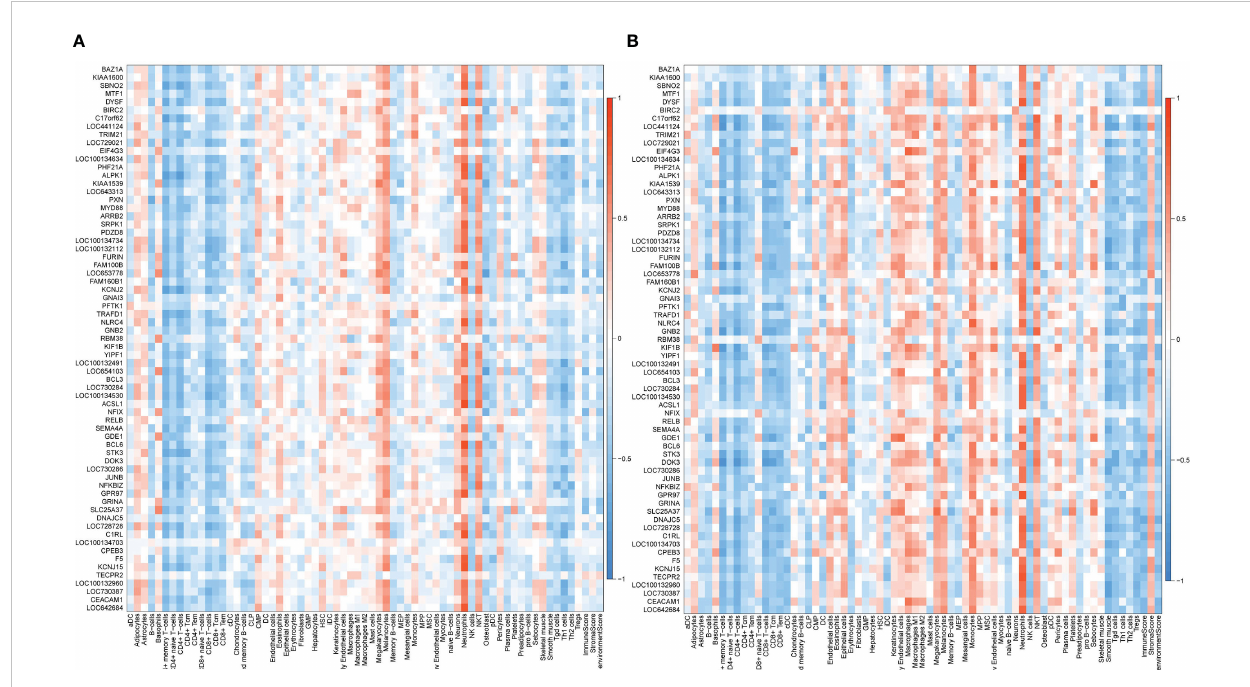
FIGURE 7 Correlation between up-regulated coDEGs and immune cells (A) Correlation between up-regulated coDEGs and immune cells in AS. (B) Correlation between up-regulated coDEGs and immune cells in